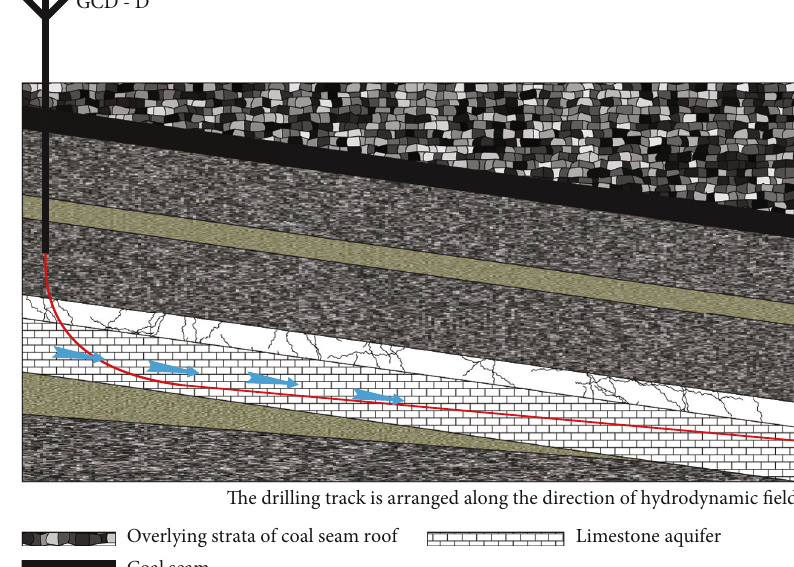
Figure 6: Schematic diagram of directional drilling arranged according to the inclined direction of the transformed rock